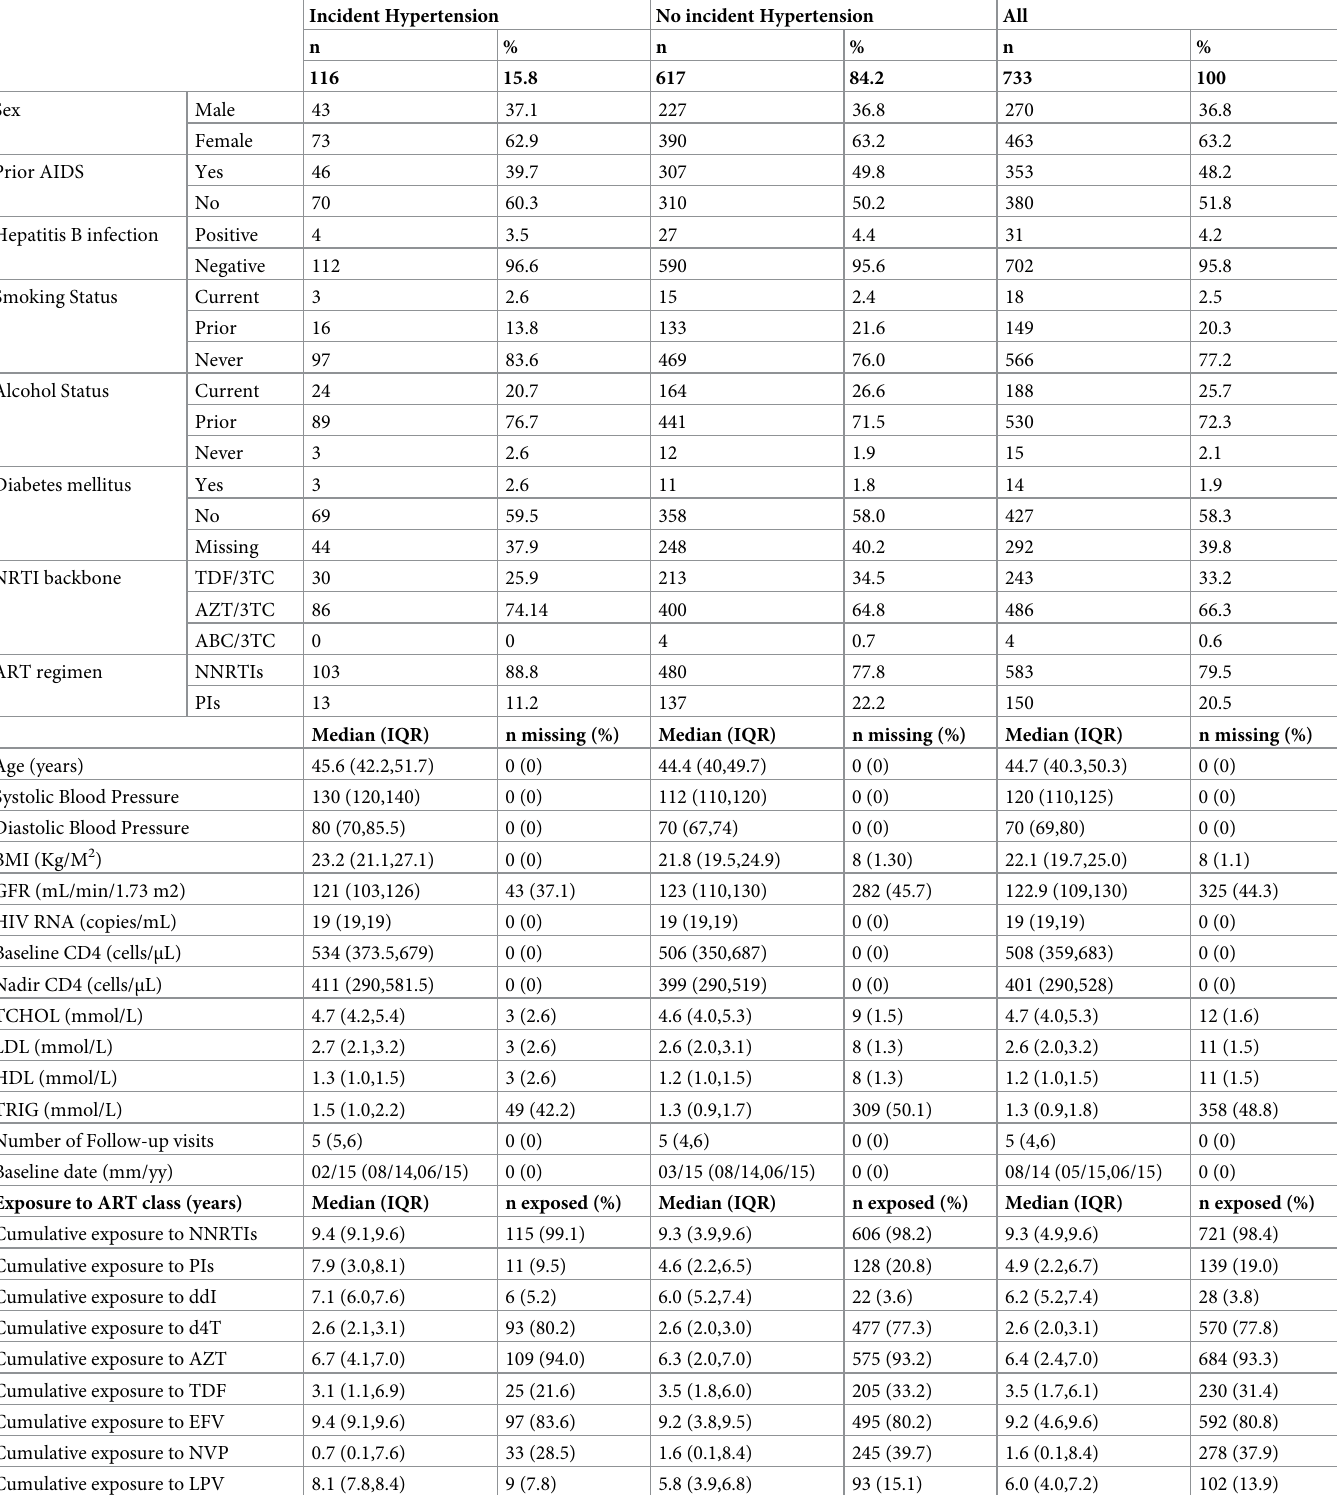
Table 3. Characteristics of participants without hypertension at baseline (n =